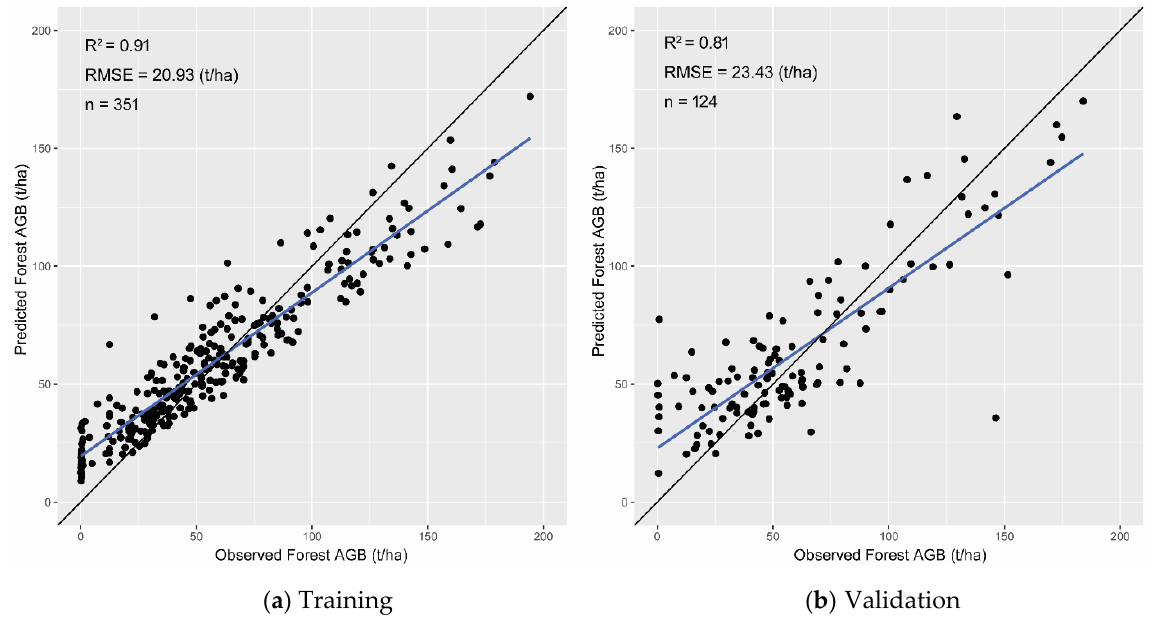
Figure 5. Observed versus predicted forest AGB applying random forest (RF) model and FY-3C VIRR imagery for ( a ) the training dataset and ( b ) the validation dataset.